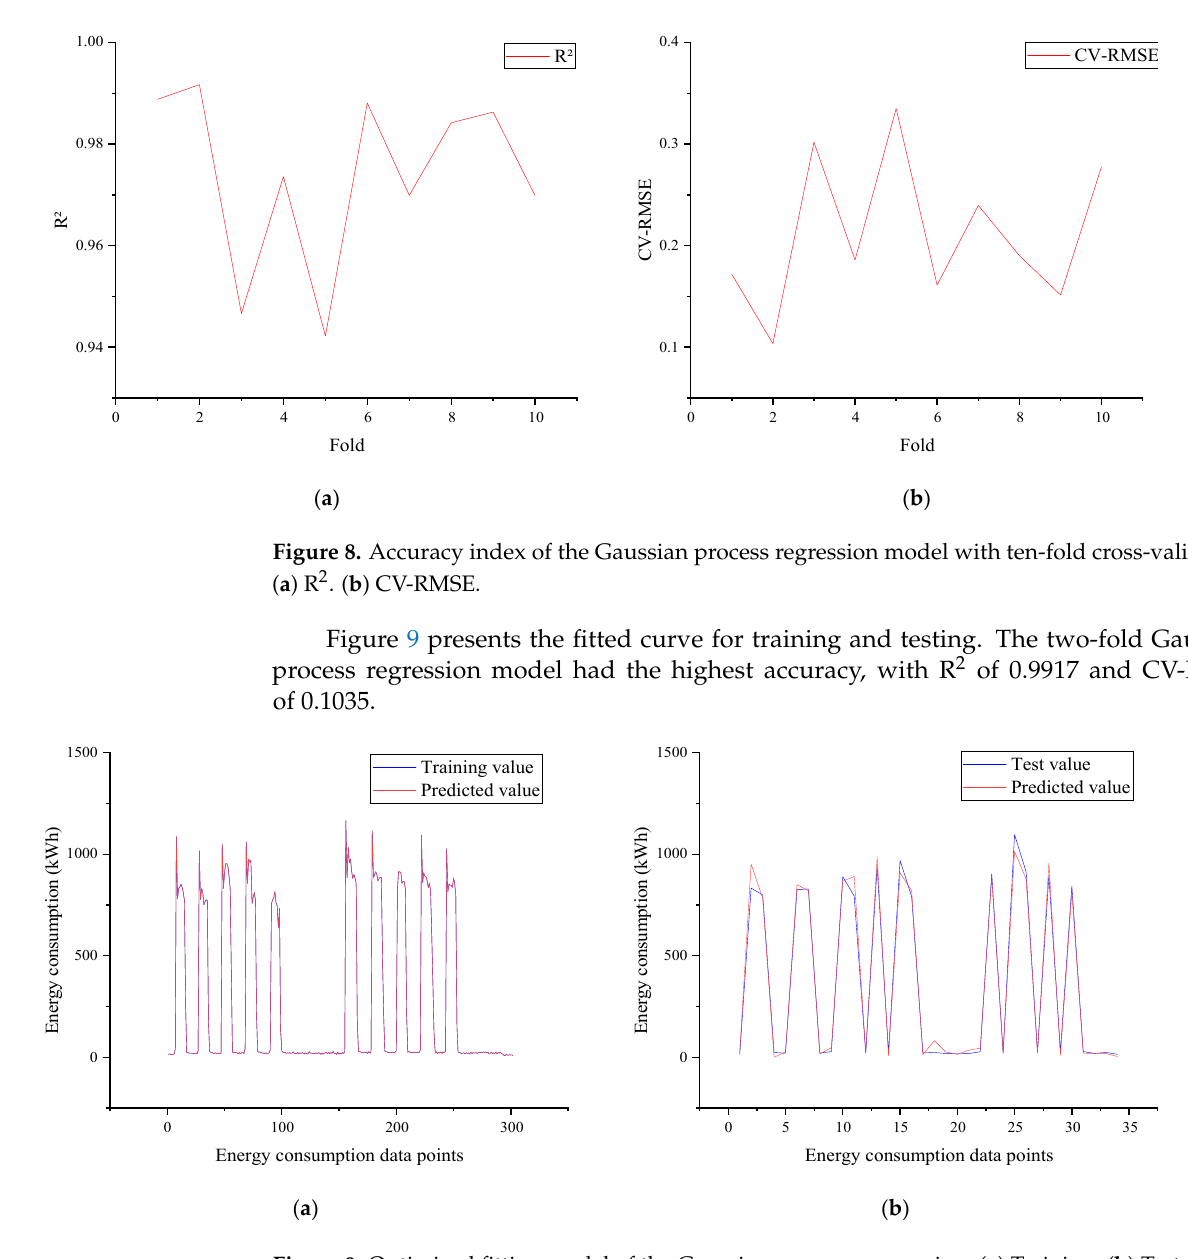
11 of 20 Figure 7. Accuracy index of the Gaussian process regression model with grid searching method . ( a ) R 2 . ( b ) CV-RMSE. Results show that the model with a total of four steps forward after the accumulation